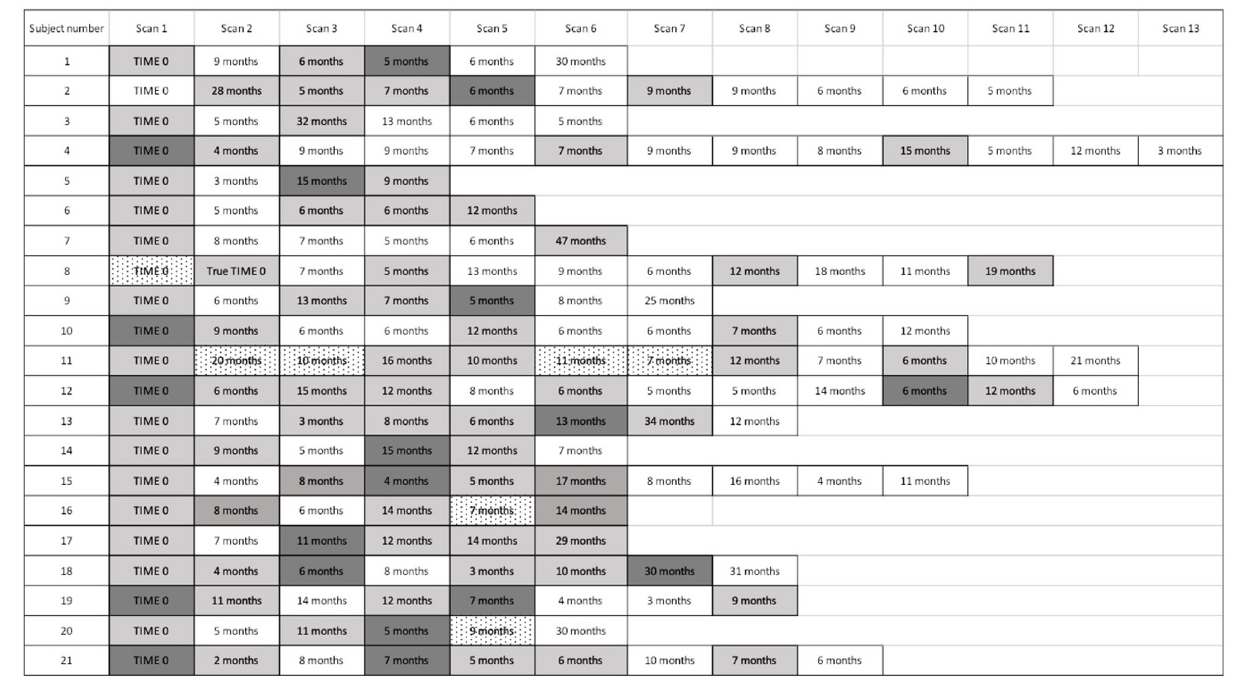
FIGURE 4 | Timeline of cardiac PET scan results. For subjects with recurrently active cardiac sarcoidosis, the number of months from the prior PET scan and PET scan results are displayed. For patients with multiple scans demonstrating disease recurrence, we identified the time to the first sign of recurrence, but used the most severely affected scan to analyse the pattern and extent of recurrence. “Time 0” indicates the first available PET scan in our system. White boxes: negative cardiac PET scan. Light gray boxes: positive cardiac PET scan. Dark gray boxes: scan with most extensive disease, when multiple sequential cardiac PET scans were positive; if serially positive scans demonstrated an equal extent of disease, no dark gray is indicated. Dotted white boxes: non-diagnostic scan due to improper dietary preparation and failed metabolic